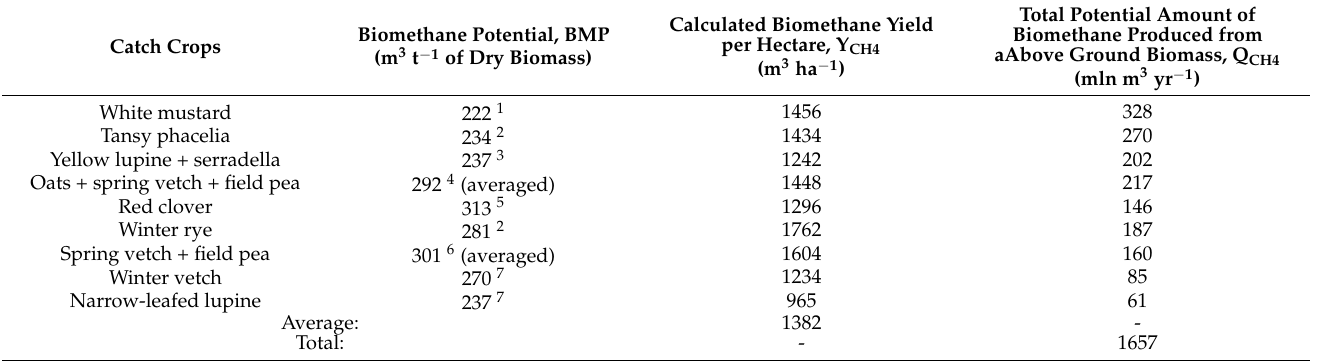
Table 4. Estimated biomethane potential and yield of biomass of catch crops cultivated in Poland.